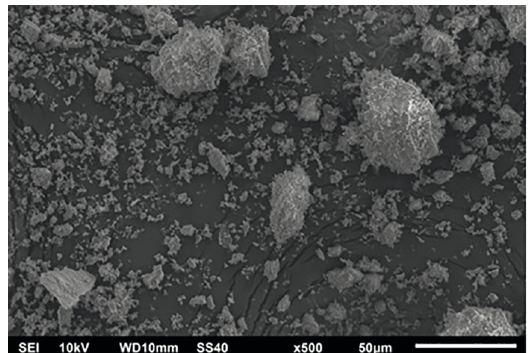
Figure 8. Kinetic curves for the adsorption of MG onto natural kaolin. Experimental conditions: pH = 6.3; T = 25 ºC; Adsorbent mass = 0.1 g; V = 100 solution